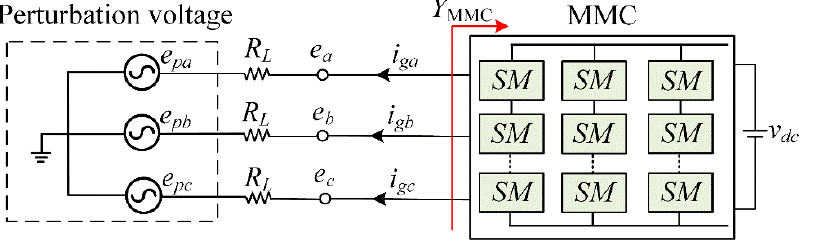
Figure 6. Configuration of the experimental setup for measuring MMC admittance.